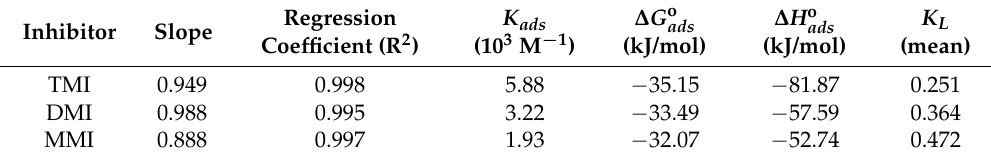
Table 2. Langmuir adsorption isotherm and thermodynamic parameters for the synthesized inhibitors. ∆ G o ∆ H o K ads K L Regression ads ads Inhibitor Slope Coefficient (R 2 ) (10 3 M − 1 ) (kJ/mol) (kJ/mol) (mean) TMI 0.949 0.998 5.88 − 35.15 − 81.87 0.251 DMI 0.988 0.995 3.22 − 33.49 −